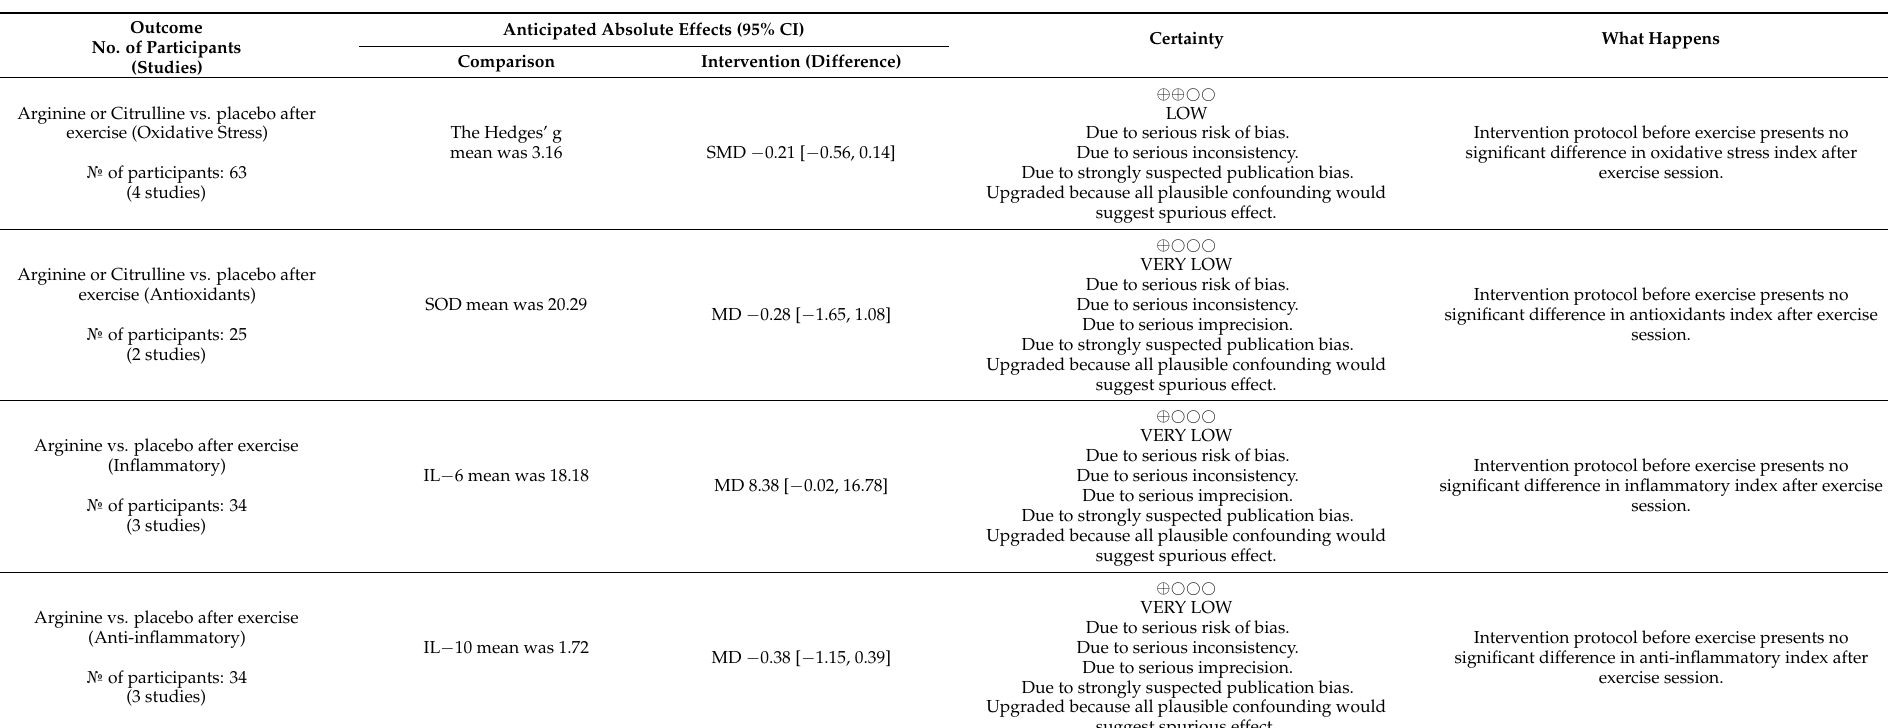
Table 2. Summary of findings (GRADE assessment): L-Arginine and L-Citrulline vs. Placebo Protocol (After Exercise) Repercussions on Oxidative Stress, Antioxidants, Inflammatory and Anti-Inflammatory Markers. Patient or population: Athletes, physically active, obese, and hypertensive subjects. HIV infected men and postmenopausal women. Intervention: Arginine or Citrulline. Comparison: